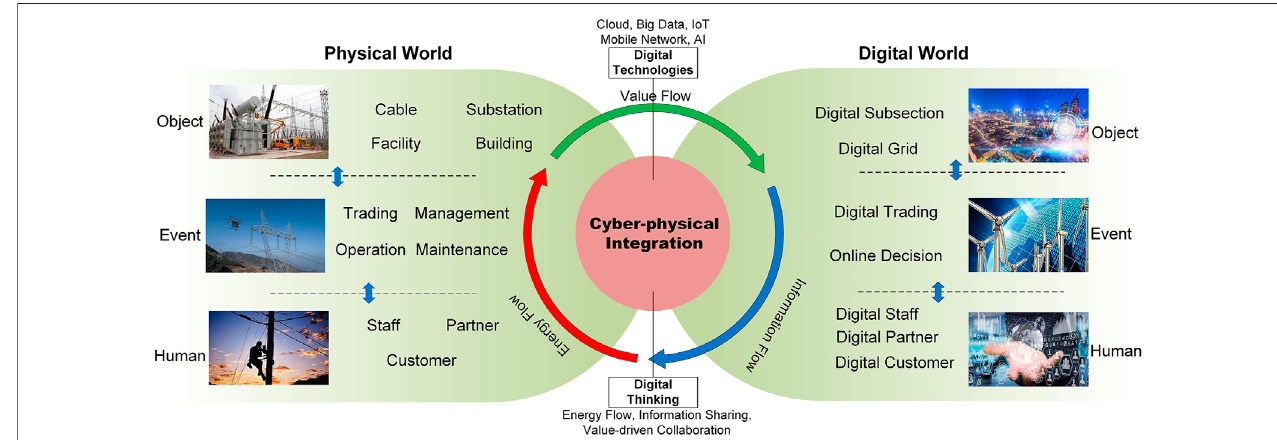
FIGURE 4 | Conceptual framework of the